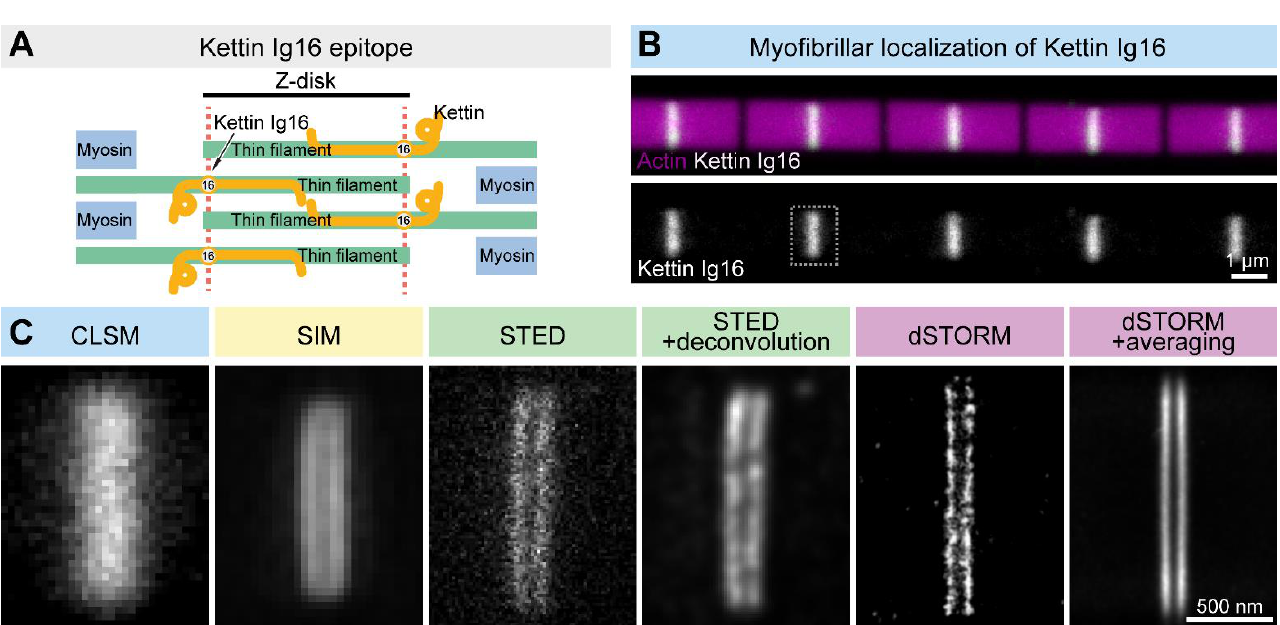
Figure 4. Comparison of the lateral resolution of the different SRM approaches. ( A ) The Kettin Ig16 epitope is found in two stripes separated by ~100 nm in the Z-disk of IFM myofibrils. ( B ) Confocal imaging of the individual myofibrils reveals the Z-disk accumulation of the Kettin Ig16 epitope. The dotted rectangle marks the Z-disk presented in panel C. ( C ) The Kettin Ig16 signal at the Z-disk appears as a single band with confocal microscopy (CLSM), which can be resolved into two individual bands with various super-resolution approaches such as SIM, STED or dSTORM. dSTORM combined with structure averaging (on the right) can produce an image with the most outstanding resolution. Table 1. Comparison of the different SRM techniques. *: low, **: medium, ***: high.